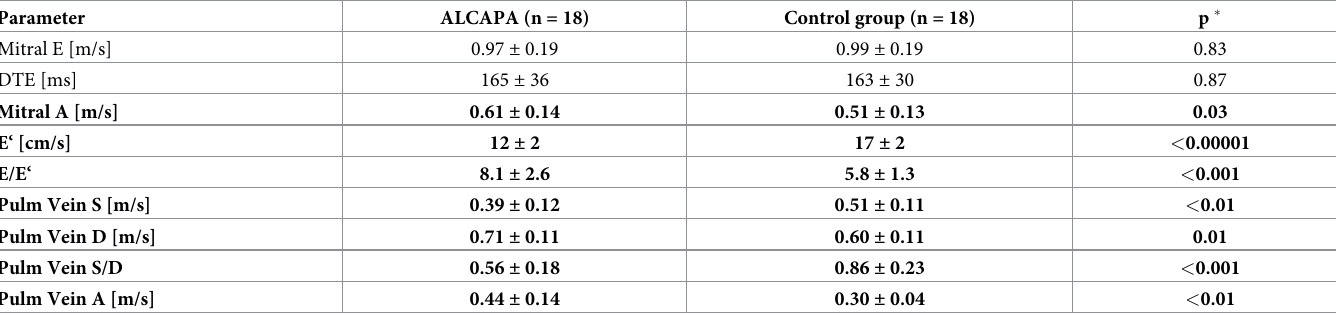
Table 3. Comparison of the echocardiographic parameters of diastolic function in the study population at last follow-up and the control group.